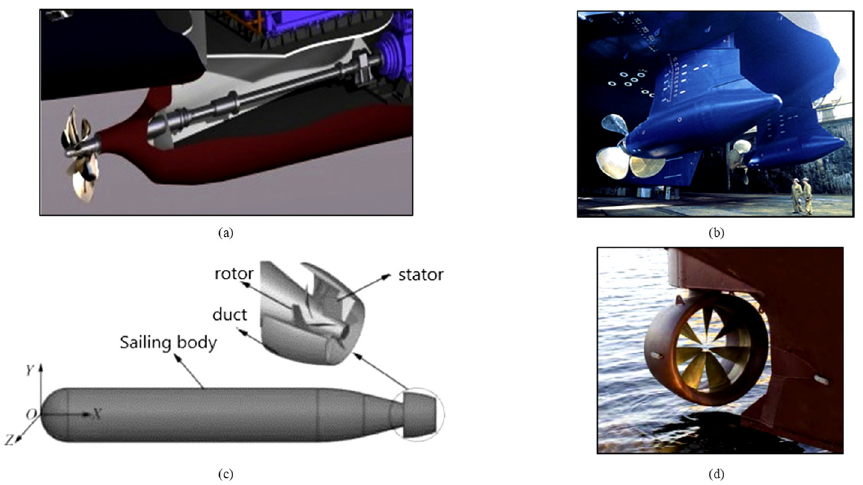
Figure 1. Different marine propulsion systems: ( a ) conventional propulsion system; ( b ) podded propulsor; ( c ) pump-jet propulsion; and ( d ) shaftless IMP [3].